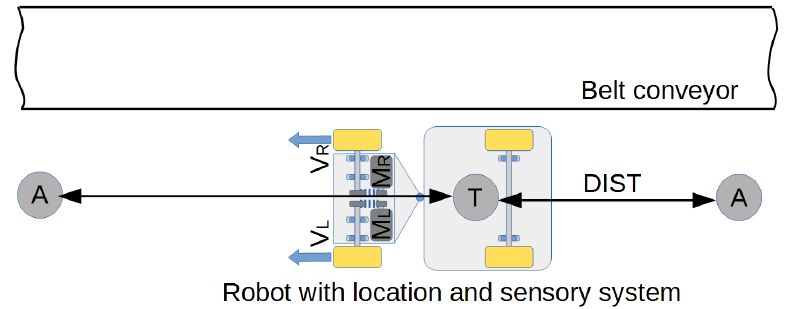
Figure 13. A plan of the experiment in the